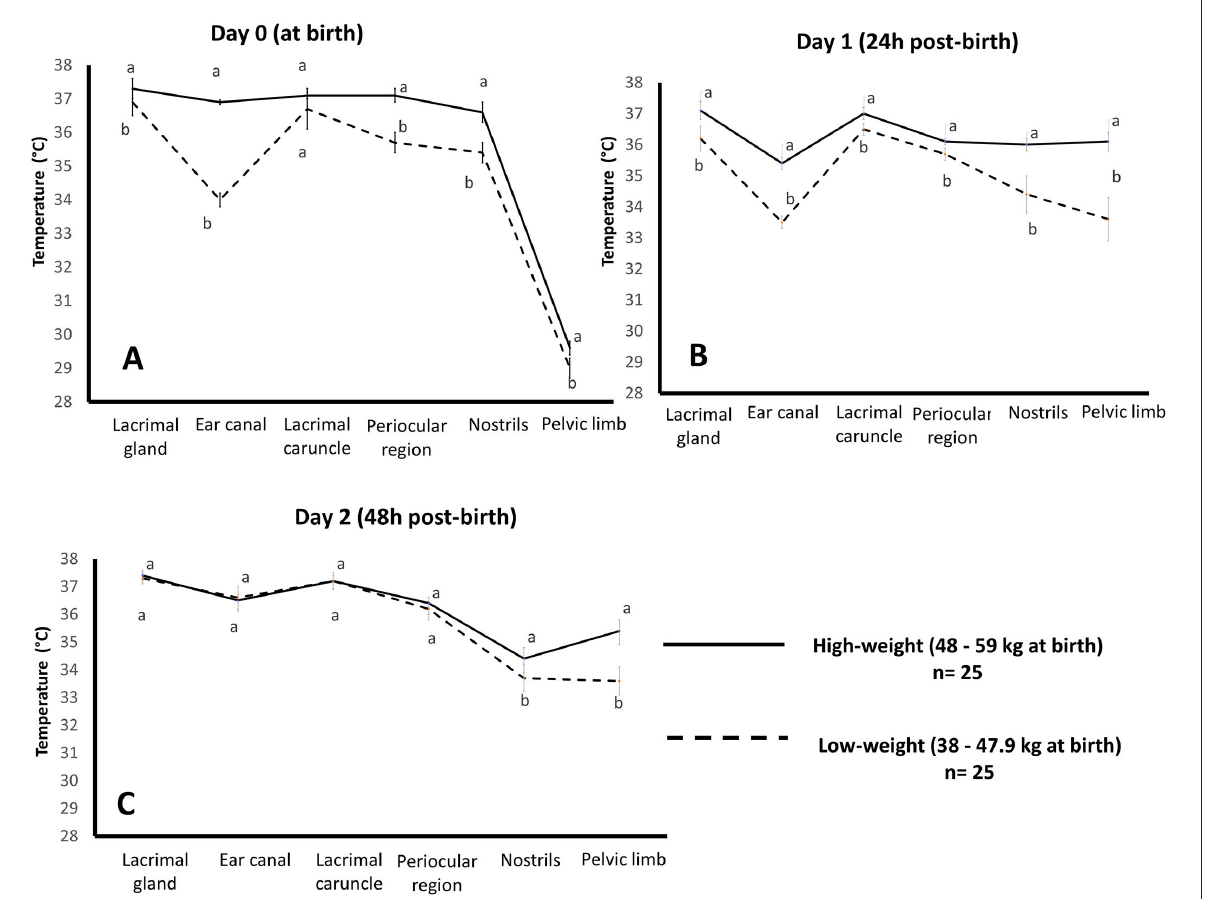
FIGURE2 Effect of birth weight on the average temperature of water buffalo neonates ( n = 50) in the first 48h of life by evaluating six thermal windows. Data was obtained using variance analysis (ANOVA) by the mixed general linear model, with multiple comparisons of means using Holm-Sidak’s test, Shapiro-Wilk normality test, and a significance level of p < 0.05. a,b Different literals indicate significant differences between groups of high- and low-weight buffalo calves ( p < 0.05). Images were taken with a FLIR camera (FLIR Systems, Boston, MA, USA), 18mm lens FOL, the emissivity of 0.95, IR resolution of 320 × 240, and a reflecting temperature of 20 ◦ C. The thermal images were processed by the software FLIR tools. (A) comparison of the mean temperature at parturition in groups with high and low birth weights, (B) comparison of the mean temperature at 24h after parturition in groups with high and low birth weights, and (C) comparison of the mean temperature at 48h after parturition in groups with high and low birth